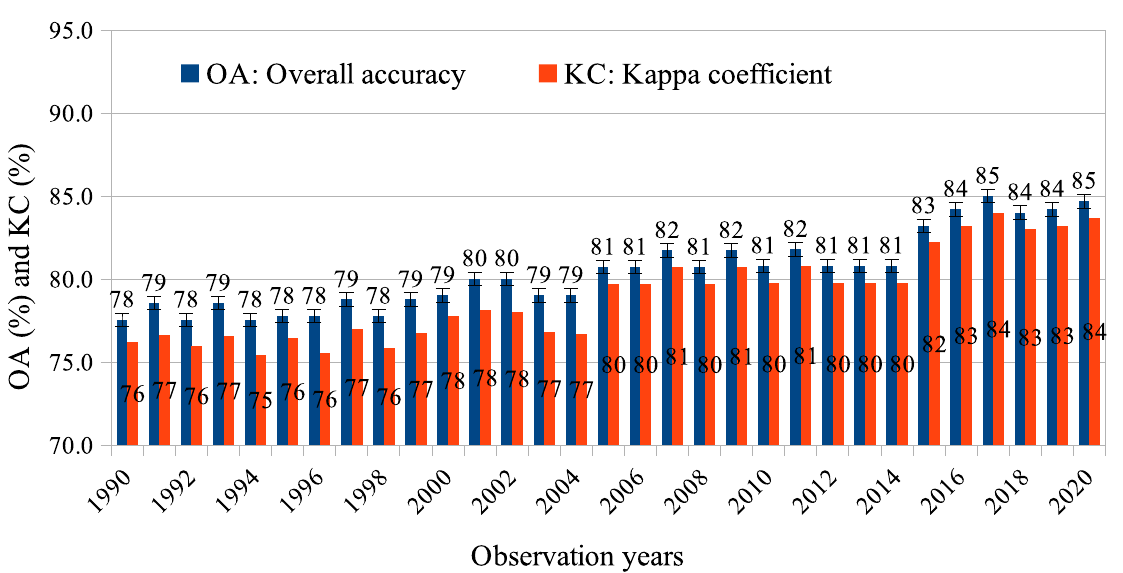
Figure 4. The overall accuracy (OA) and kappa coefficient (KC) of the level-2 Vietnam-wide annual land use/ cover maps produced from all the freely available Landsat TM, ETM + and OLI, and Sentinel SAR GRD and MSI images with the random-forest-based algorithm. The OA and KC are obtained by using a confusion matrix and a stratified validation method with independent samples (1050 points/LULC category). The bars indicate uncertainties of OA measured with a 95% confidence